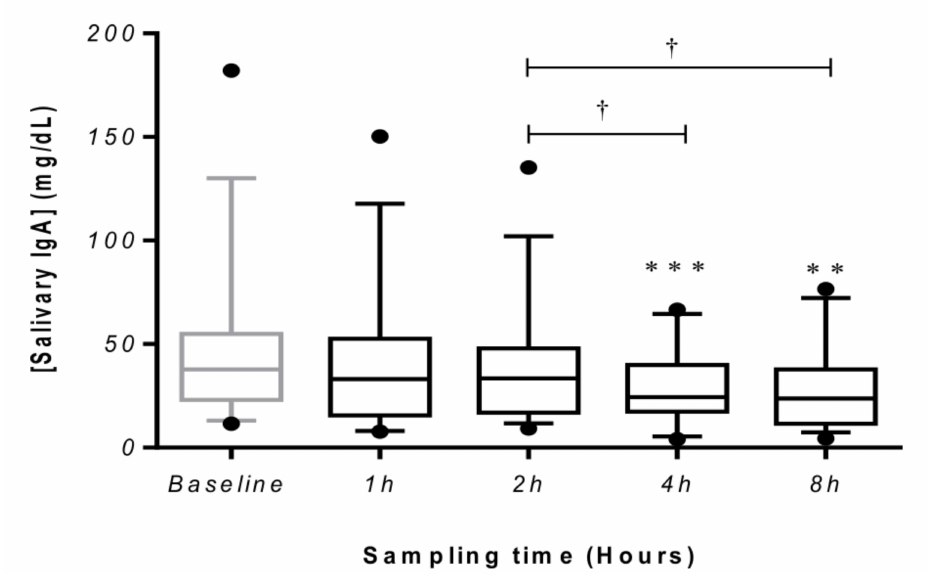
Figure 6. Salivary IgA changes box plots. The boxes (25–75th percentiles) show the median con- centrations of salivary marker (line within the box) and whisker plots represent the minimum (5th percentiles) and maximum values (95th percentiles). ** p < 0.01 and *** p < 0.001 compared to baseline values. † p < 0.05 comparing between different sampling times. N =